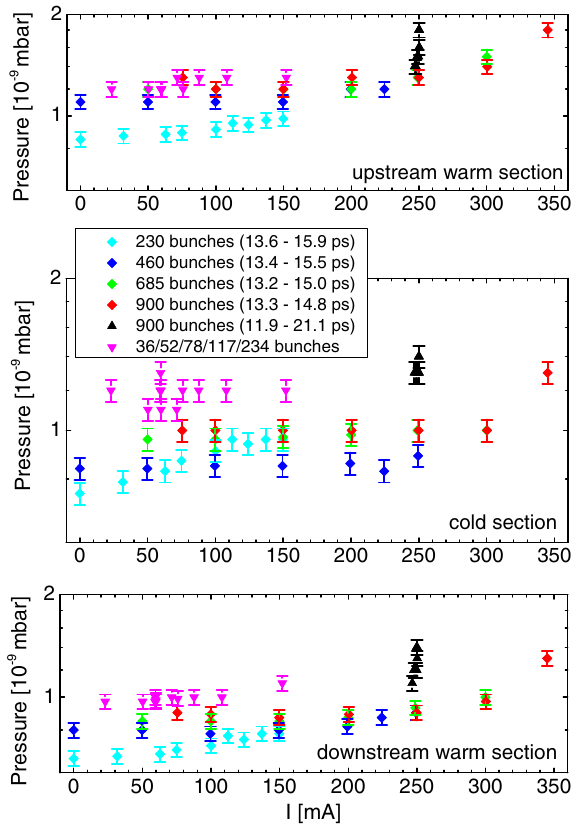
FIG. 7. Total pressure as a function of beam current in the cold section and the two warm sections of COLDDIAG for several filling patterns. The reproducibility of the pressure reading is 5% [12].